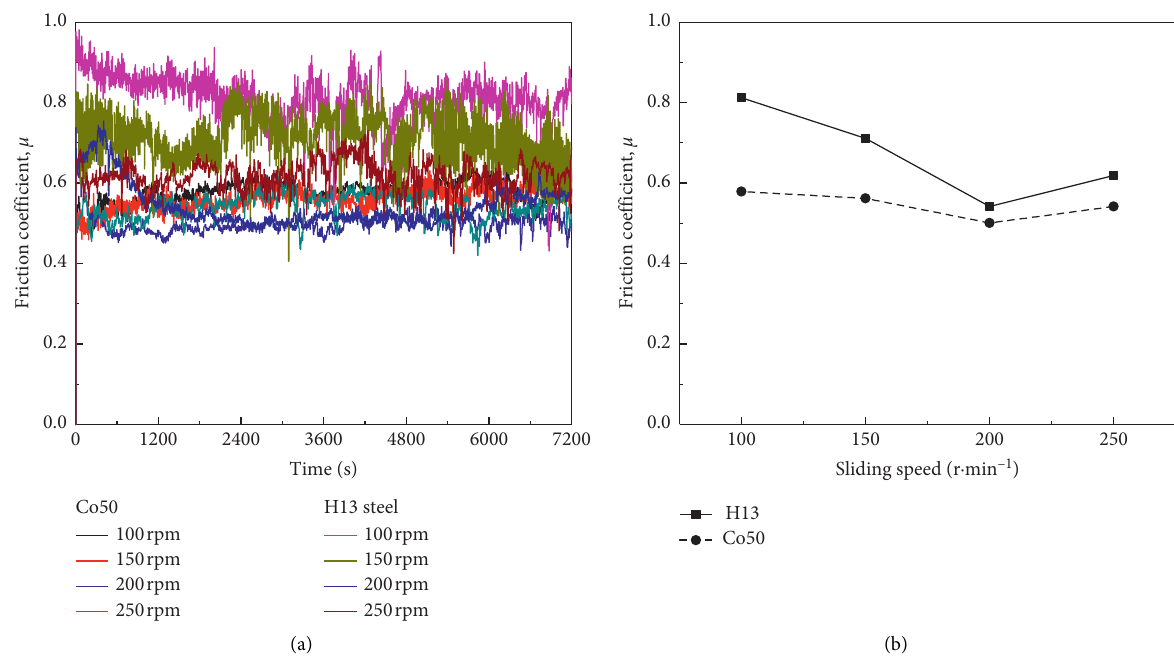
Figure 7: Effect of sliding velocity on the friction coefficient at the load of 100N: (a) S0 coating and H13 steel; (b) the average friction coefficient.